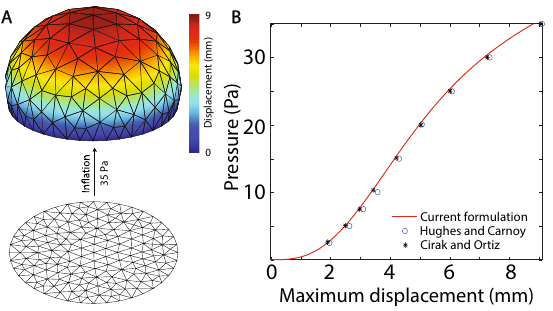
Figure 5. Verification of the current implementation against literature data. ( A ) Shows the initial and the deformed configuration of a simply supported circular plate inflated under uniform pressure. ( B ) Compares the pressure vs. maximum displacement obtained from our implementation against literature